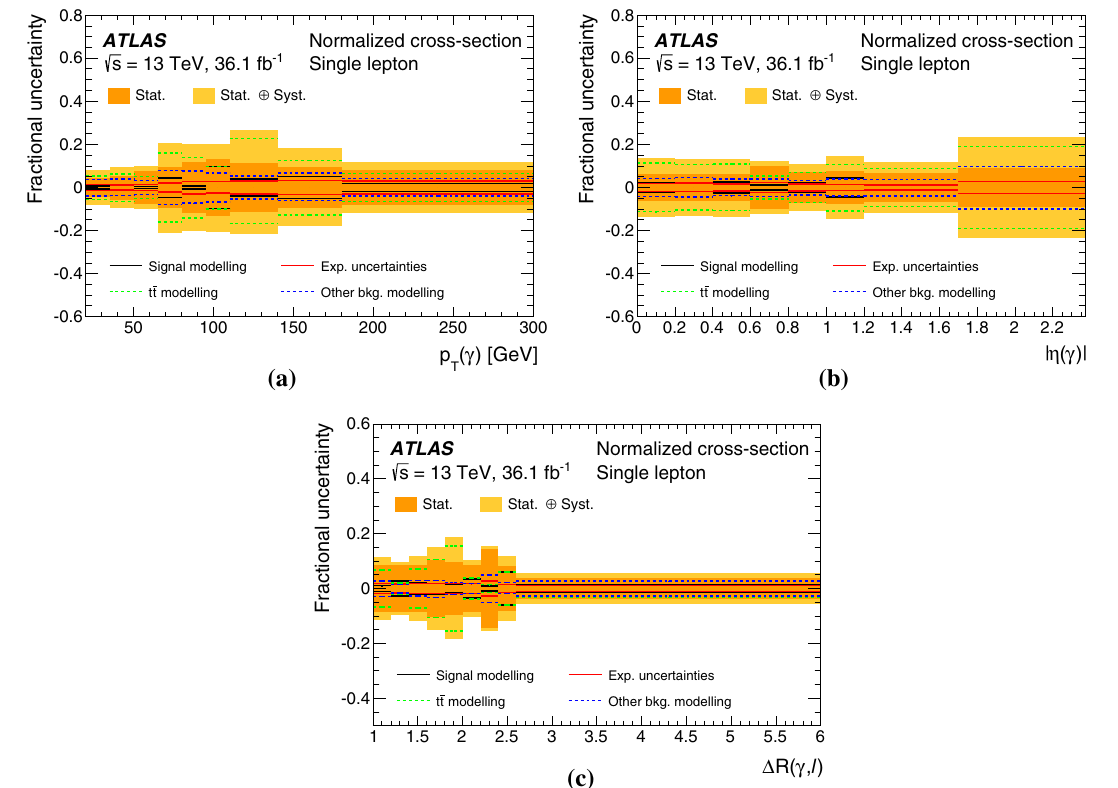
Fig. 11 The decomposed systematic uncertainties for the normalized differential cross-sections as a function of the a photon p T , b photon | η | , and c (cid:7) R (γ,(cid:8)) in the single-lepton